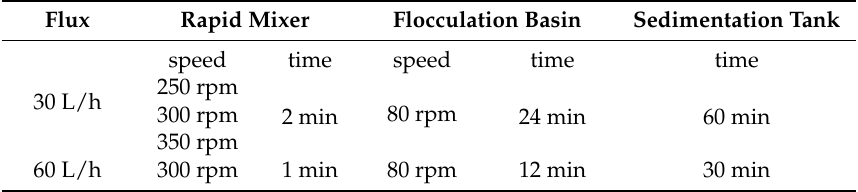
Table 2. Operational conditions of coagulation